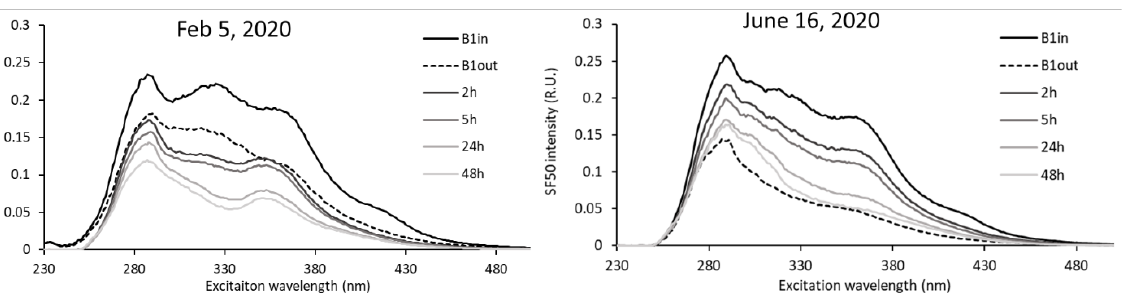
Figure 9. Synchronous fluorescence spectra during the photolysis experiments B (5 February 2020) and C (16 June 2020).